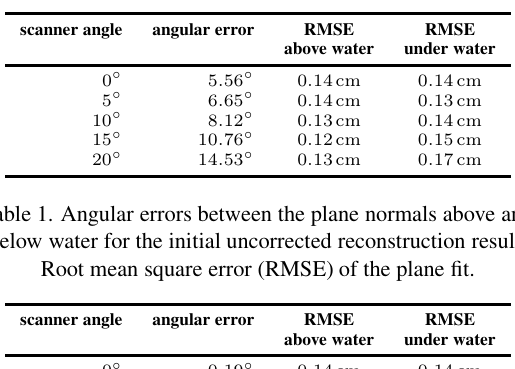
Figure 9. Left: Two markers attached rigidly to the structured light scanner for trajectory tracking. Middle: Measurement of reference points for the co-calibration of the tracker and scanner coordinate system. Right: Measurement of the water surface for the verification of the estimated laser plane parameters.